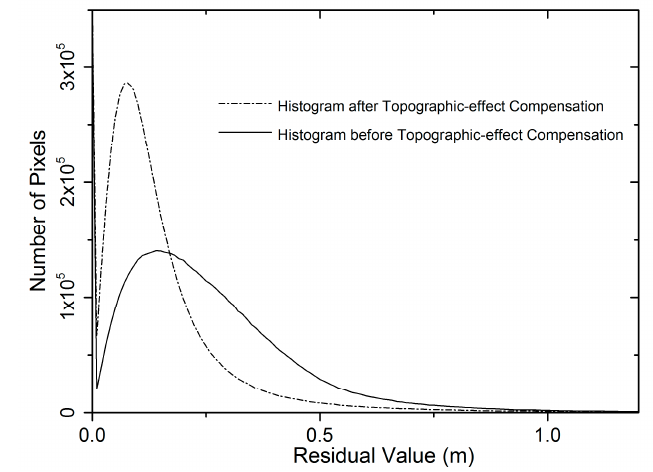
Figure 7. Histogram of the residual offset value in the non-glacial region.